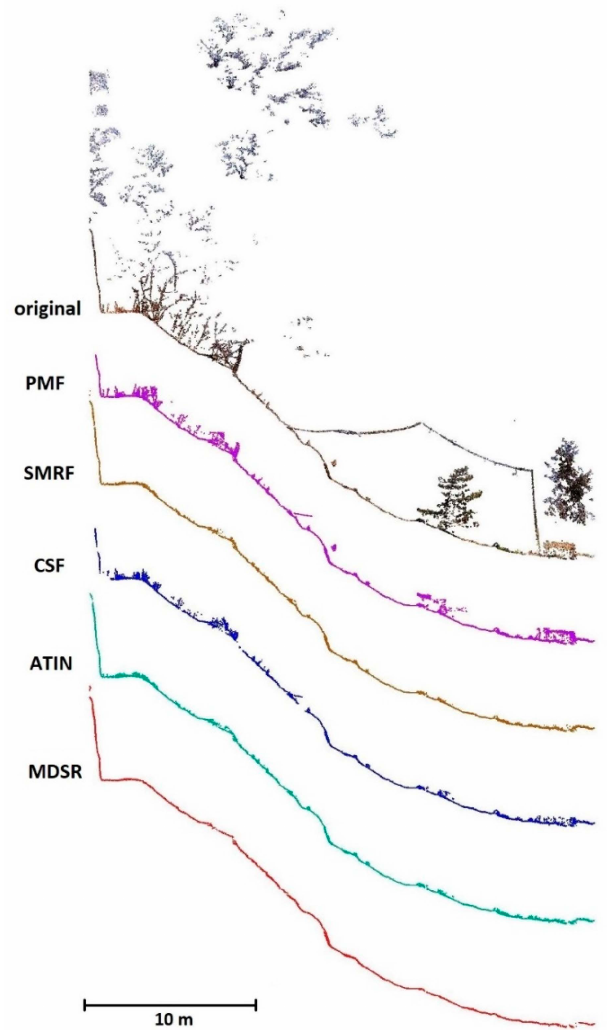
Figure 10. Profiles from site 3 filtering: gray—original cloud; purple—PMF; brown—SMRF; blue— CSF; green—ATIN; red—MDSR.